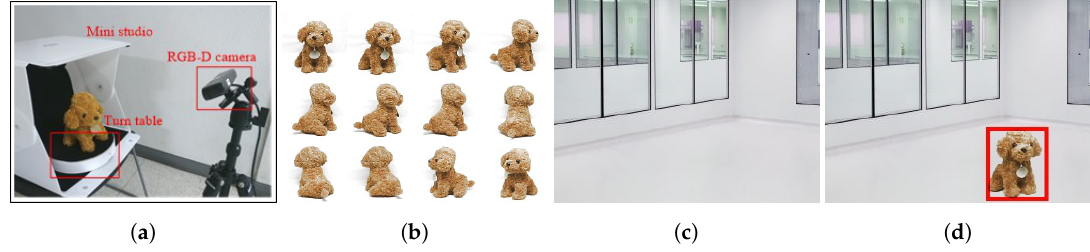
Figure 2. Automated generation of training data. ( a ) Turntable and studio setup, ( b ) Captured object images, ( c ) Background image and ( d ) Synthesized training